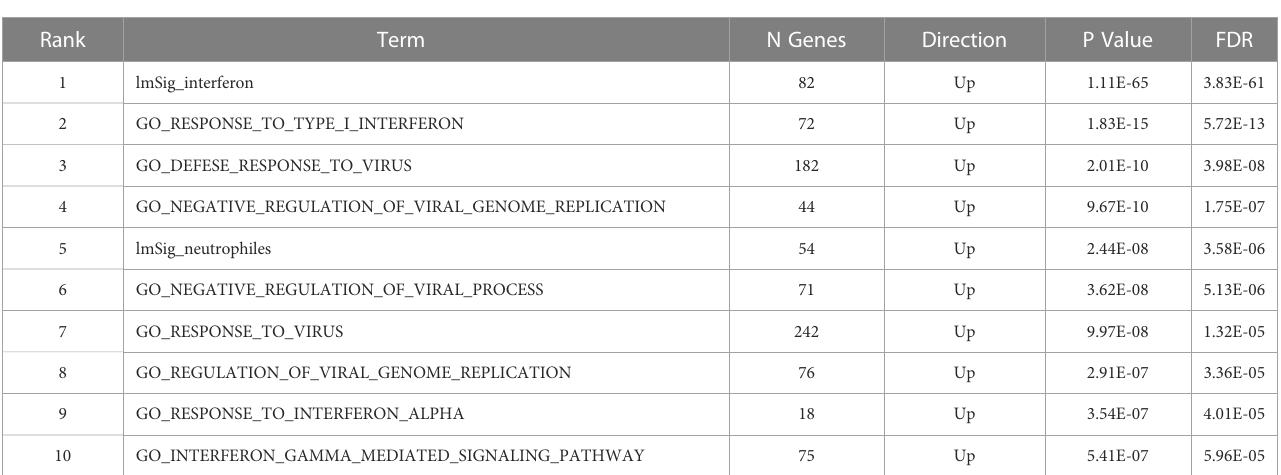
TABLE 1 Pathway analysis of RNA-seq